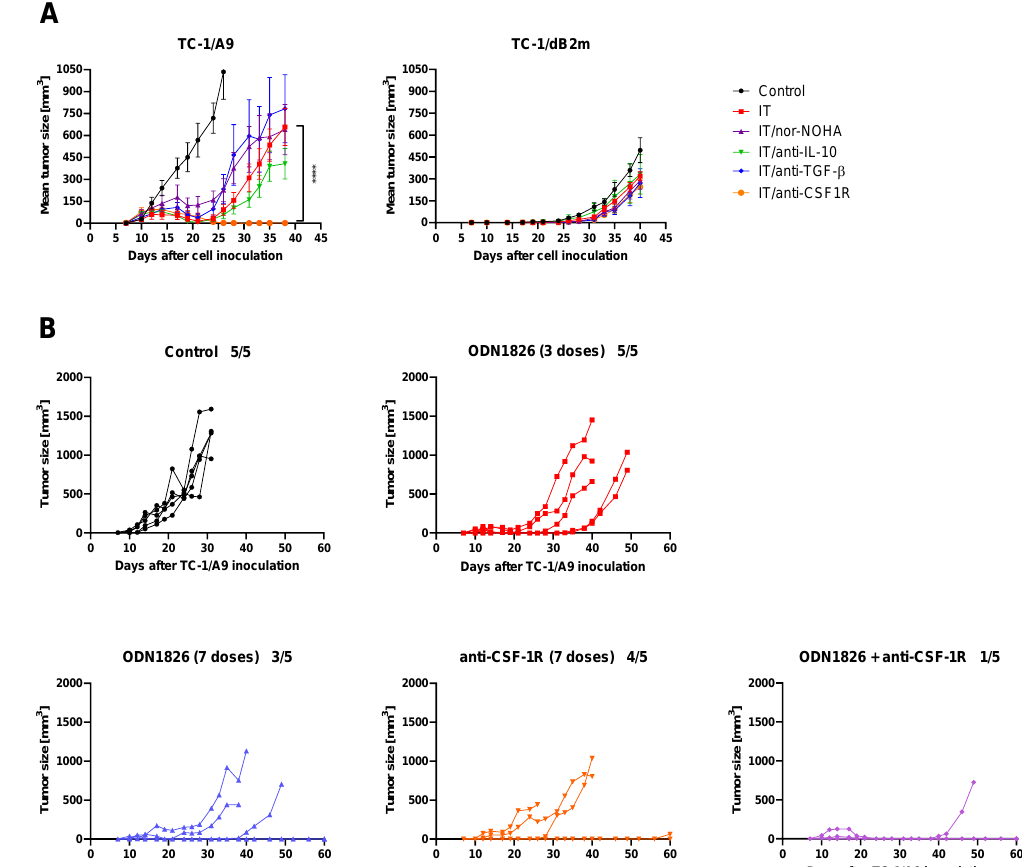
Figure 6. The anti-tumor effect induced by combined IT of tumors with reduced MHC-I expression. ( A ) In Vivo inhibition of immunosuppressive factors. Mice ( n = 5) were injected with TC-1/A9 or TC-1/dB2m cells and treated with combined IT consisting of DNA immunization and i.p. injection of ODN1826 adjuvant. Arginase activity was inhibited with the nor-NOHA inhibitor, and IL-10, TGF- β , or CSF-1R were neutralized with monoclonal antibodies, as described in Materials and Methods. Bars: ± SEM; **** p < 0.0001. Statistical significance refers to the comparison with the group treated with DNA immunization and ODN1826. ( B ) Tumor growth in single mice after different variants of ODN1826 and/or anti-CSF-1R administration. Mice ( n = 5) were injected with TC-1/A9 cells and immunized with a gene gun and subsequently received the ODN1826 adjuvant, anti-CSF-1R, or their combination, as described in Materials and Methods. Number of mice with tumor/number of mice in a group.